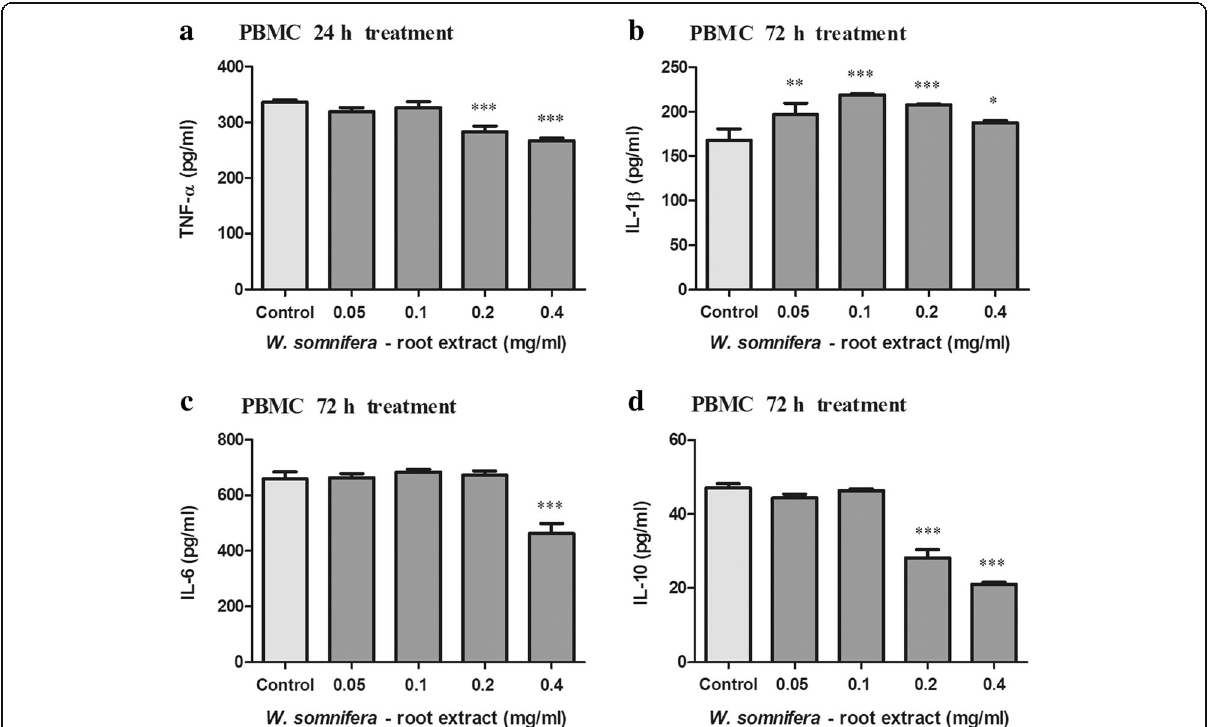
Fig. 3 Concentration of TNF- α ( a ), IL-1 β ( b ), IL-6 ( c ) and IL-10 ( d ) in LPS stimulated and W RE treated PBMC ’ s (Values expressed as mean±SD, * p <0.05, *** p <0.0001, compared to the